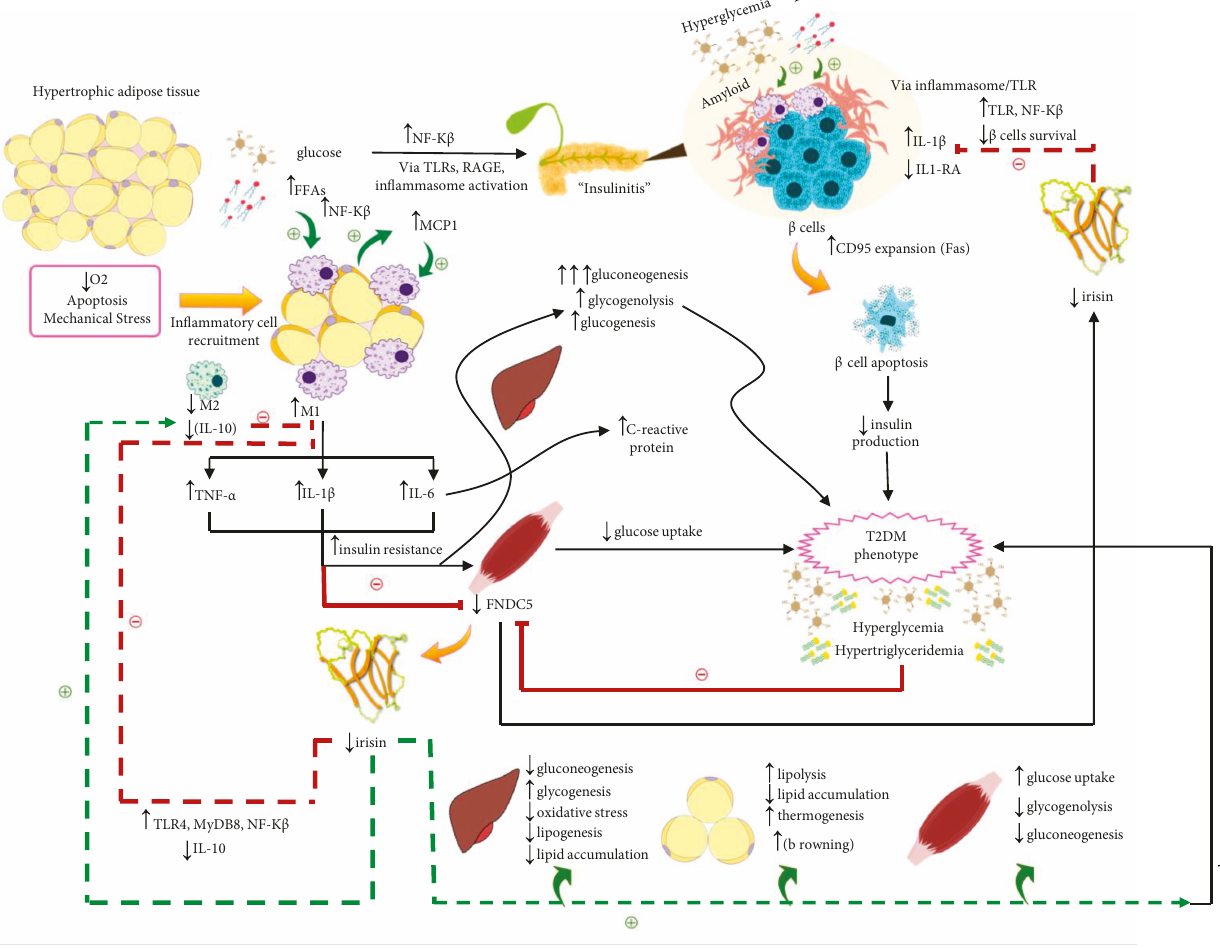
Figure 4: Possible irisin-in fl ammatory cross talk in overt T2DM and exacerbation of metabolic derangements due to hypoirisinemia. Dotted lines indicate the theoretical compensatory e ff ects of higher irisin levels in context of obesity, which may be impaired in patients with T2DM who have decreased levels of irisin. Continuous lines indicate an e ff ect that could be observed in context of T2DM. Green lines indicate stimulation and red lines indicate inhibition. FFAs =free fatty acids; FNDC5= fi bonectin type III domain-containing protein 5; IL- 1RA=interleukin-1 receptor antagonist; IL-1 β =interleukin-1 β ; IL-6 =interleukin-6; IL-10 =interleukin-10; LPS=lipopolysaccharide; M1 =classically activated (proin fl ammatory) macrophage; M2 =alternatively activated (anti-in fl ammatory) macrophage; MCP1=monocyte chemoattractant protein 1; MyD88=myeloid di ff erentiation primary response 88; NF- κ B=nuclear factor kappa B; TLR =toll-like receptor; RAGE =receptor for advanced glycation end products; T2DM =type 2 diabetes mellitus; TNF- α =tumor necrosis